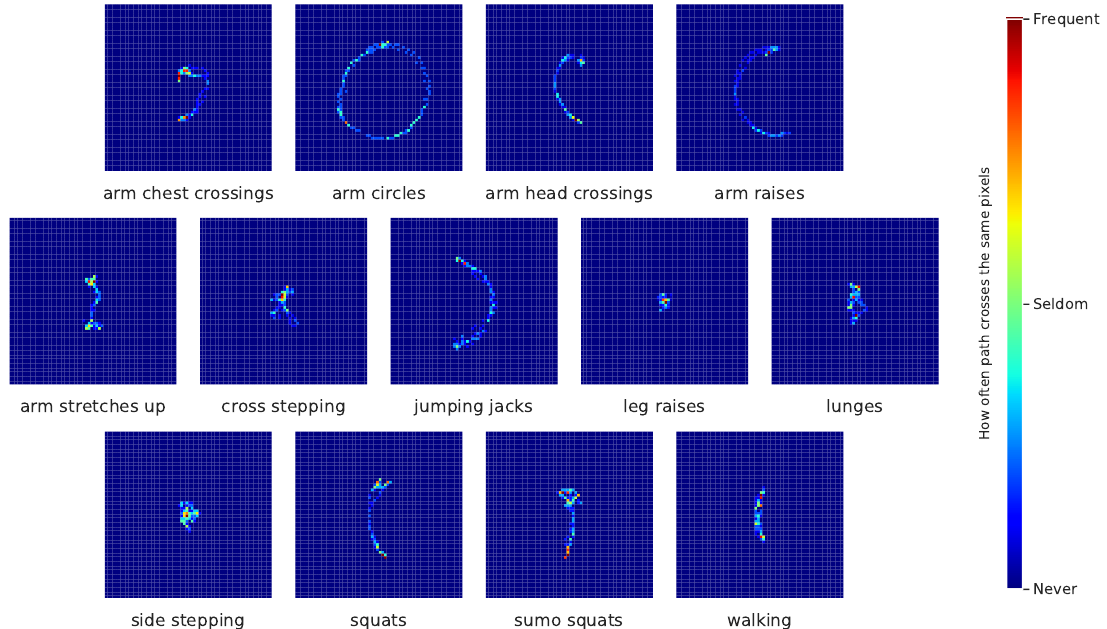
Figure 7. Examples of heatmaps for a generated trajectory of the right wrist for each class of activity.